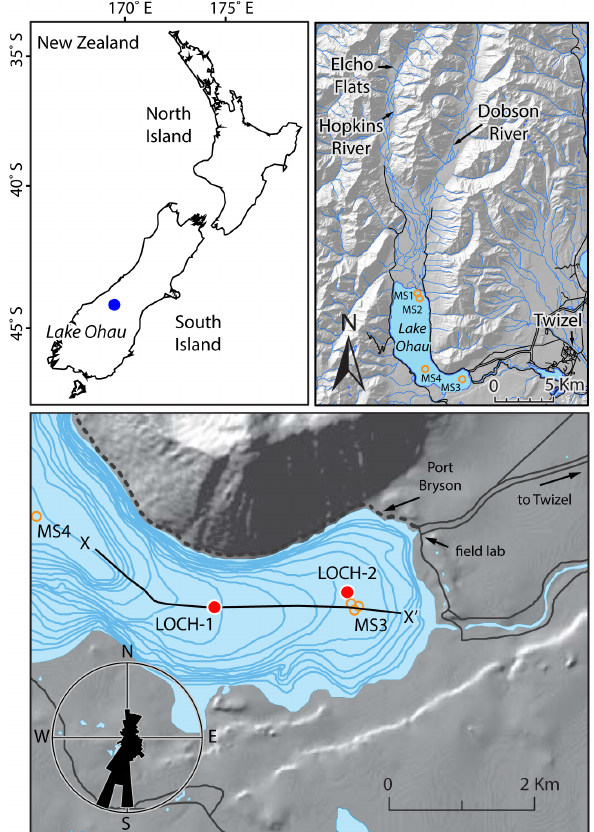
Figure 1. Location of Lake Ohau, South Island, New Zealand. Or- ange circles: monitoring sites 1–4; red dots: LOCH drill sites; line X–X (cid:48) : location of the seismic line illustrated in Fig. 3. Gravel ac- cess road indicated by the dashed line in the bottom panel. The rose diagram shows that the dominant wind direction is from the north-